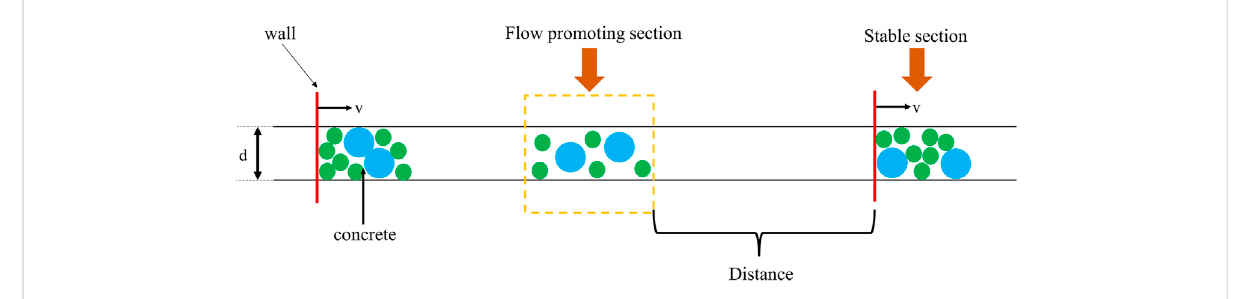
FIGURE 6 The process of numerical